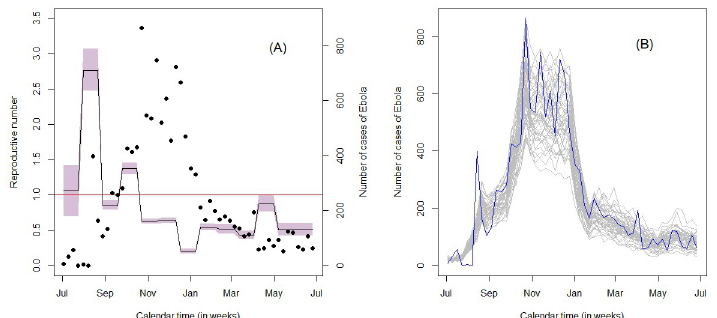
Fig 5. Effective reproductive number and simulated incidence of EVD. (A) Posterior effective reproductive number (black solid line) for the nationwide data with its 95% credible interval(shaded area). The horizontal red line corresponds to the epidemic threshold, R = 1. The black dots correspond to the observed cases of Ebola. (B) Stochastic t simulation of the incidence data from the marginal posterior distribution of ( β ( t ), 1/ % , 1/ γ , E (0), I (0)).